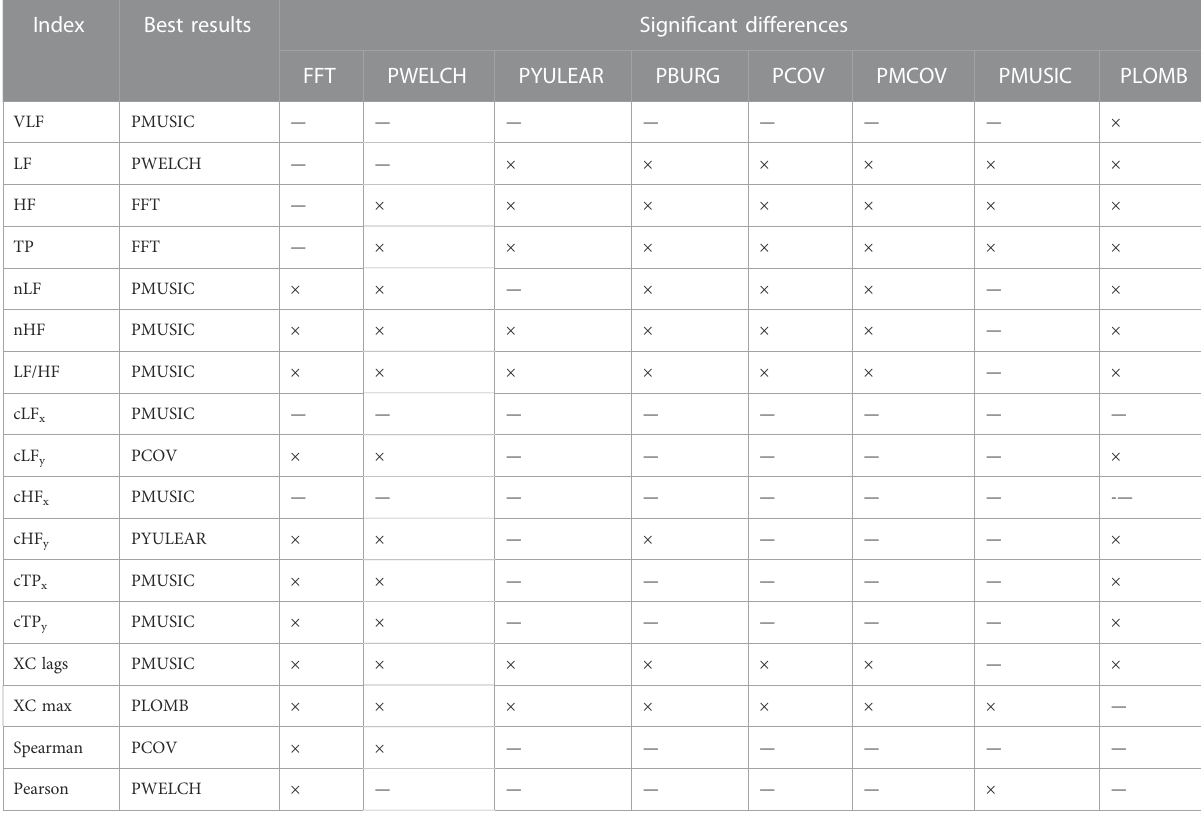
TABLE 4 Summary of results obtained from the Kruskal-Wallis one-way analysis of variance and post hoc comparisons for pulse rate variability obtained from excellent quality PPG signals. ×: Signi fi cant differences. — : Non-signi fi cant